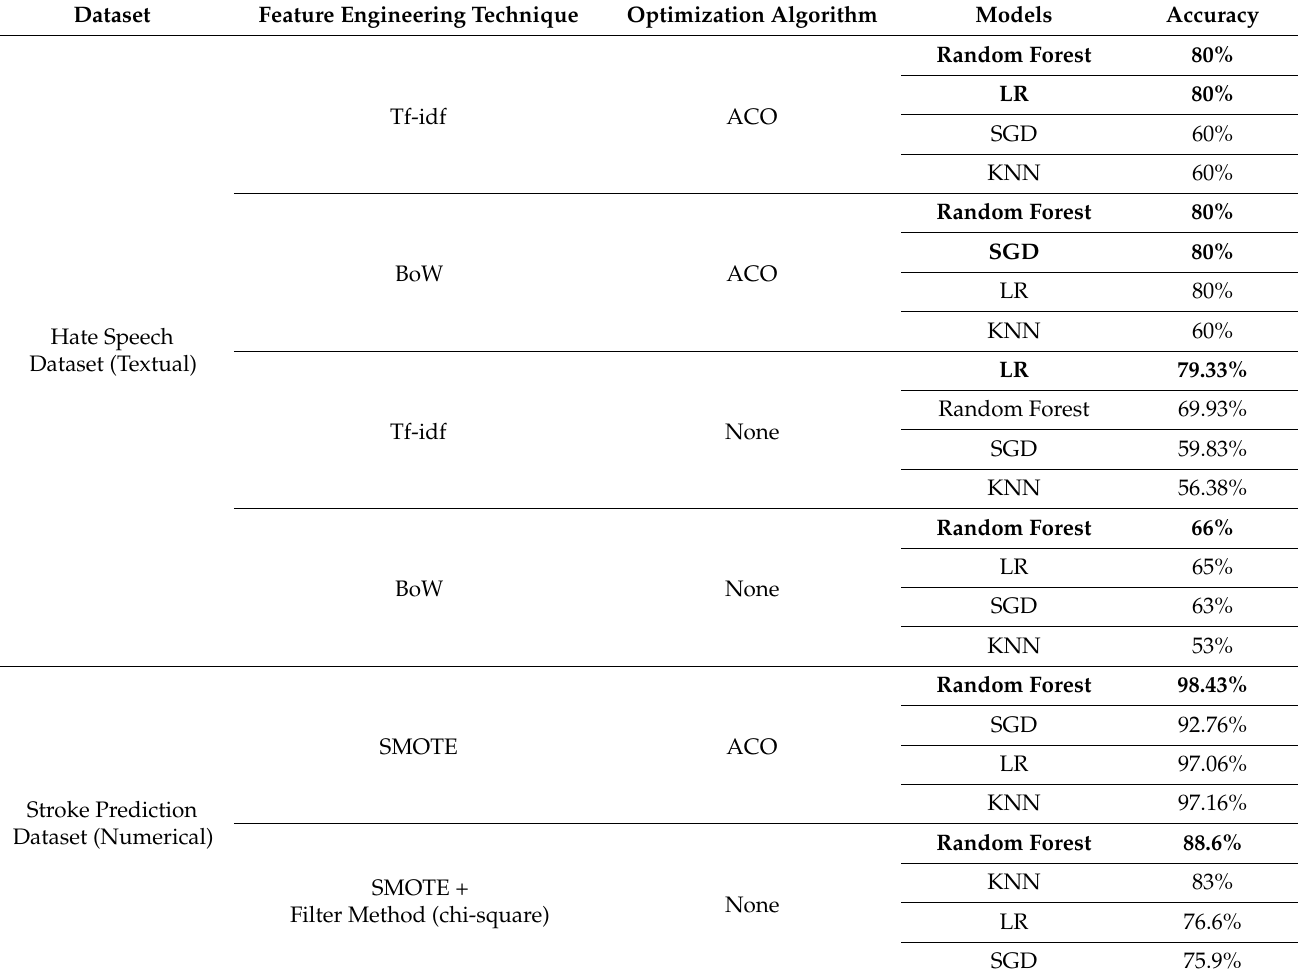
Table 4. Dataset evaluation with and without ACO